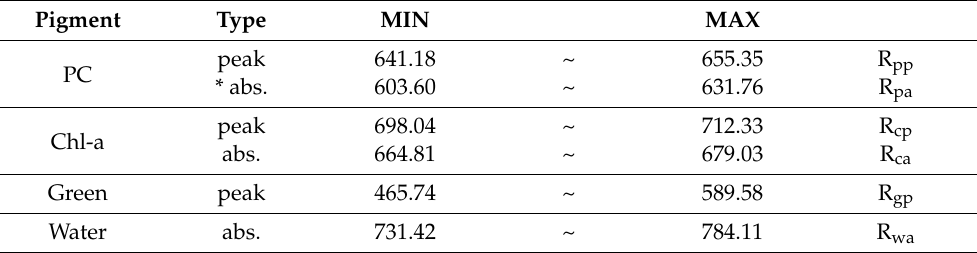
Table 3. Cyanobacteria key features’ reflectance bands